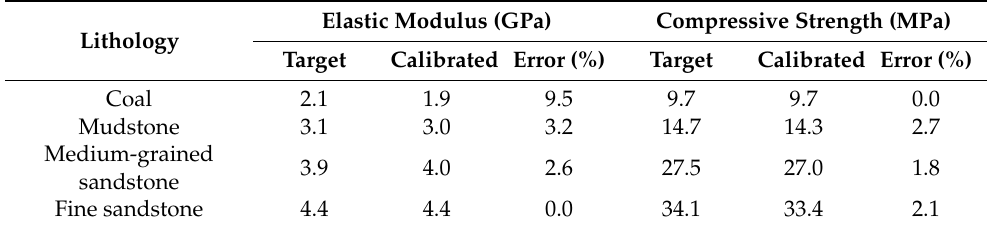
Table 2. Comparison between calibrated parameters and target